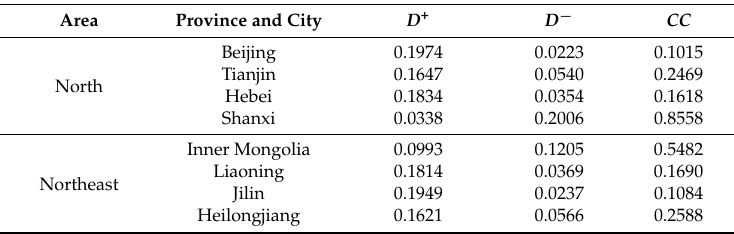
Table 3. The CC j values calculated by Equation